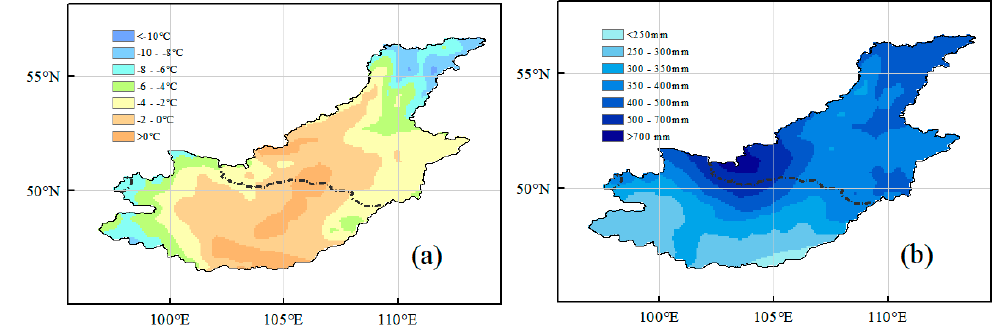
Figure 2. Spatial distribution of the average annual temperature ( a ) and precipitation ( b ) from 1982 to 2015.